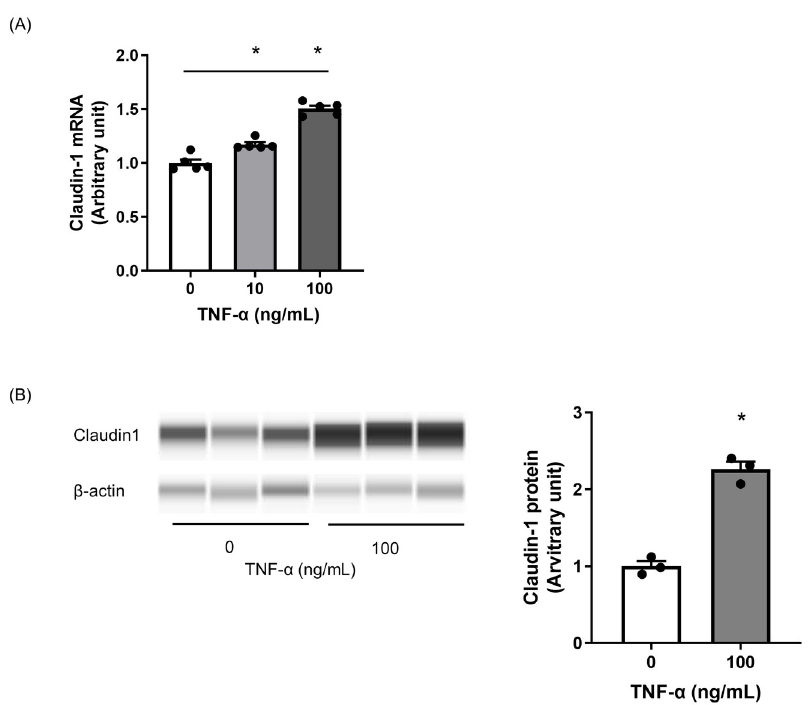
Fig 6. Increase of CL-1 expression by TNF- α treatment in hTERT/RPTEC cells. RPTEC/TERT cells were treated with TNF- α for 48 hours. CL-1 mRNA (A) and protein (B) expression levels were elevated by TNF- α treatment. Relative mRNA expression and protein were calculated as the ratio to GAPDH and β -actin, respectively. The quantification of CL-1 was shown by the ratio to non-treatment cells. The actual values are represented as dots and the columns represent mean + SE. � p < 0.05, significant difference versus control (Student’s t-test).